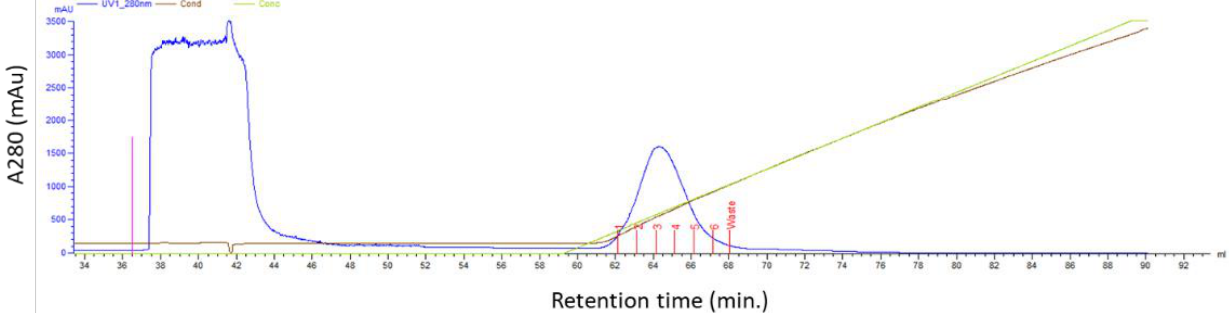
Figure 2. Ion exchange chromatography. The bacterial extract containing high levels of the untagged Z HER2:2891 DCS was subjected to an ion exchange chromatography (CM sepharose Fast Flow 1 mL column) in HEPES buffer at pH 8.1. The affibody was eluted using a NaCl gradient (see material and methods).